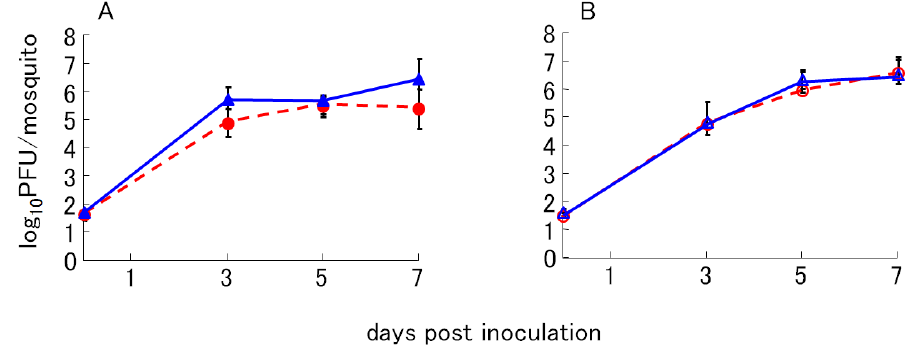
Figure 4. Virus titer of WN virus variants in Culex pipiens pallens. Seven days old female mosquitoes (n = 4) were inoculated intrathoracically with 100 PFU of all variants. The virus titers in mosquito bodies were measured by plaque assay on BHK cells. The virus titers of 6-LP ( ▲ ) and 6-SP ( ● ) were shown in ( A ) and those of B-LP ( △ ) and B-SP ( ○ ) were shown in ( B ).